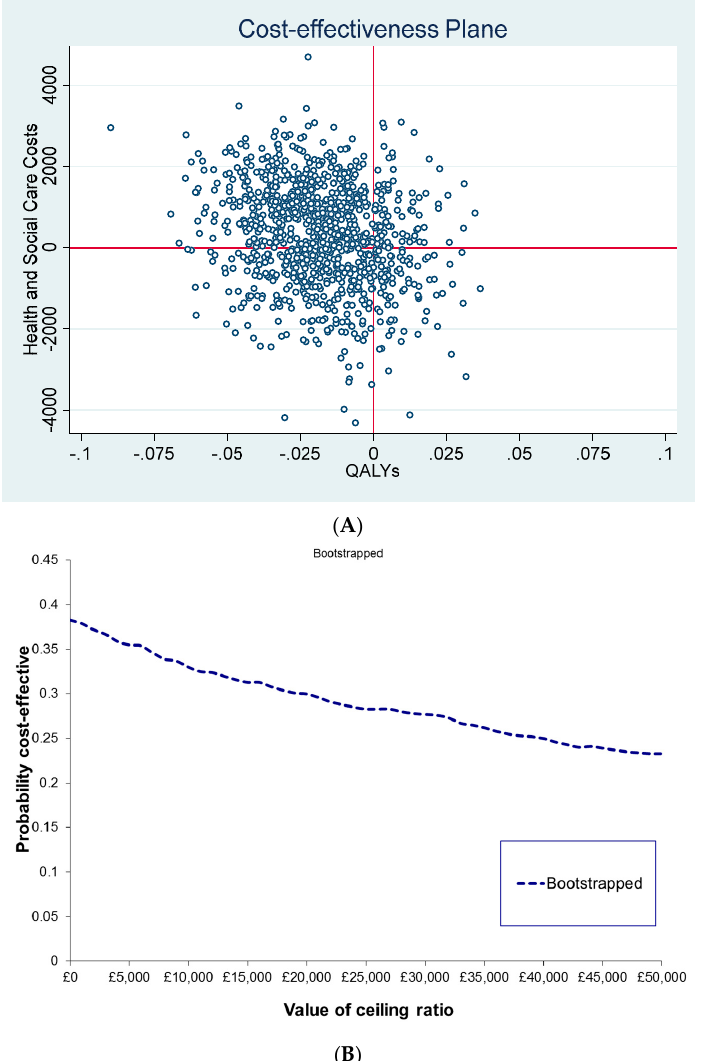
Figure 1. Uncertainty in the cost-effectiveness results (health and social care perspective). ( A ) Cost-Effectiveness Plane: Bootstrapped ICERs (PoMeT vs. TAU); ( B ) Cost-Effectiveness Accepta- bility Curve (CEAC): Probability of PoMeT being cost-effective in comparison to TAU at different willingness-to-pay thresholds for QALY gained.